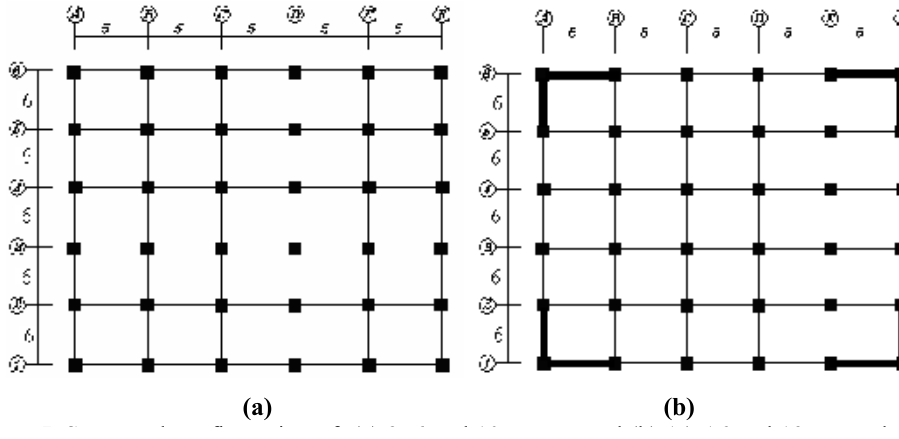
Figure 5. Structural configuration of: (a) 3, 6 and 10-storey; and (b) 14, 16 and 19-storey buildings Figure 6. Elastic acceleration response spectra of far-fault ground motion recordings used in the evaluation of each building